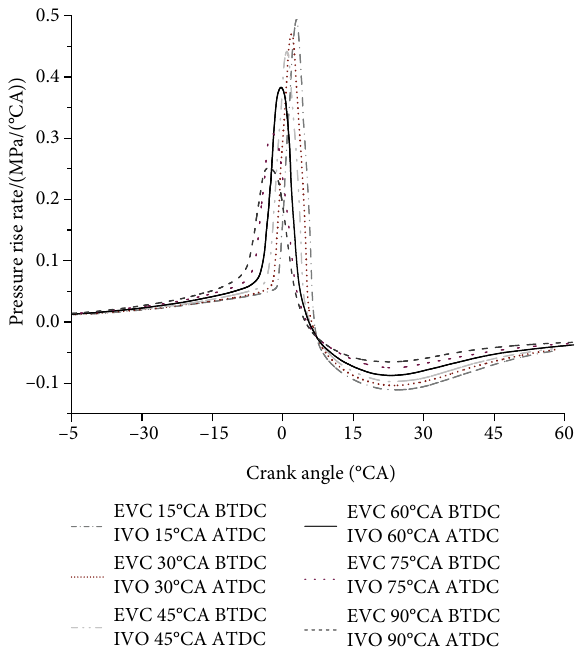
Figure 23: In fl uence of symmetric NVO on pressure rise rate.